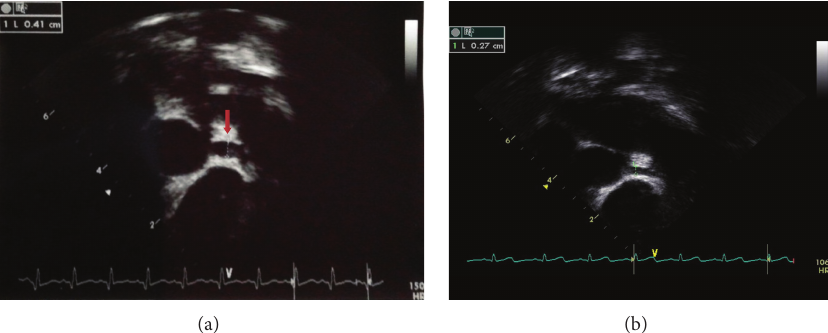
Figure 2: The echocardiographic findings on the 16th day of admission show fusiform aneurysm (4.1mm) of left main coronary artery (a) but mild dilatation of left main coronary artery (2.7 mm) after the 4th IVIG treatment